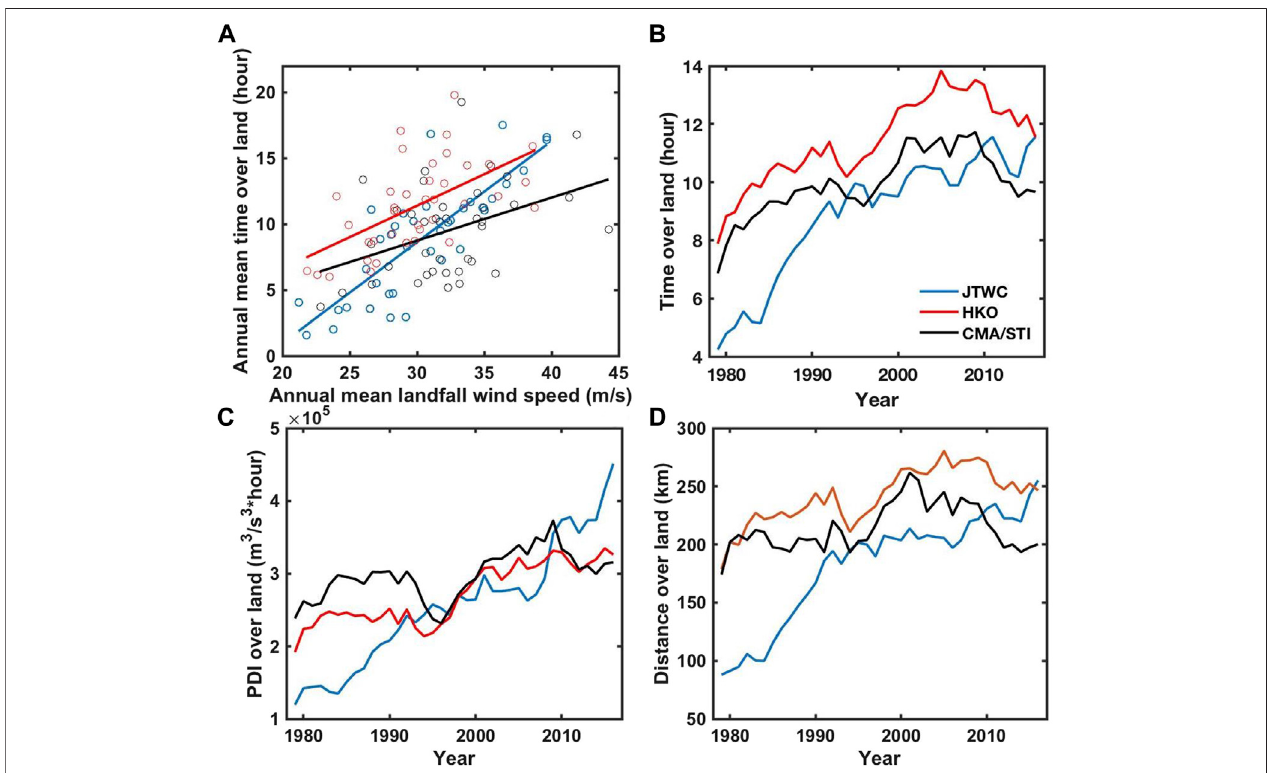
FIGURE 4 | Changes of the in fl uences of WNP TCs over land since the 1979. (A) Relationship between annual mean landfall intensity and time duration over the land; (B – D) are the 11-year moving averaged sustaining time, PDI, and travelling distance over the land from JTWC, HKO, and CMA/STI best track datasets,